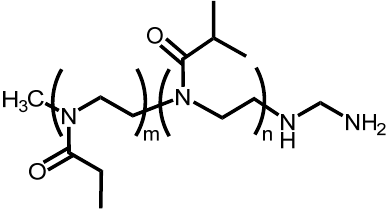
Figure 2. Chemical structure of POZ derivative investigated in this